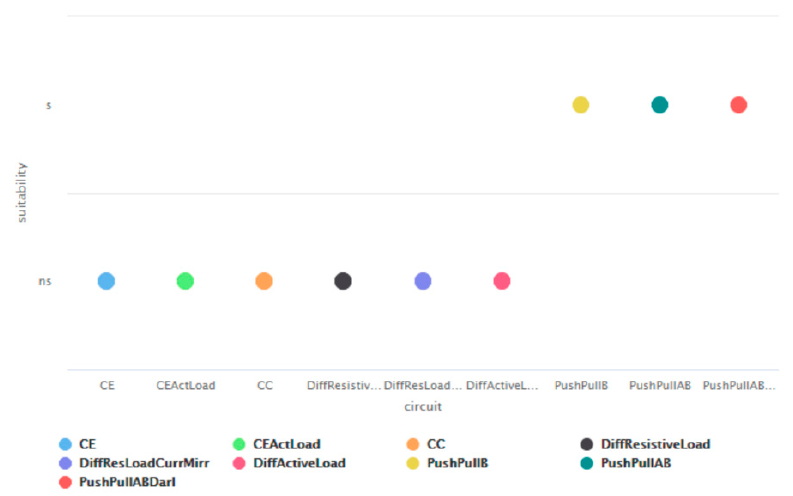
Figure 9. Dependence between circuits of stages and their suitability for realizing the amplifier output (s—suitable, ns—not suitable).